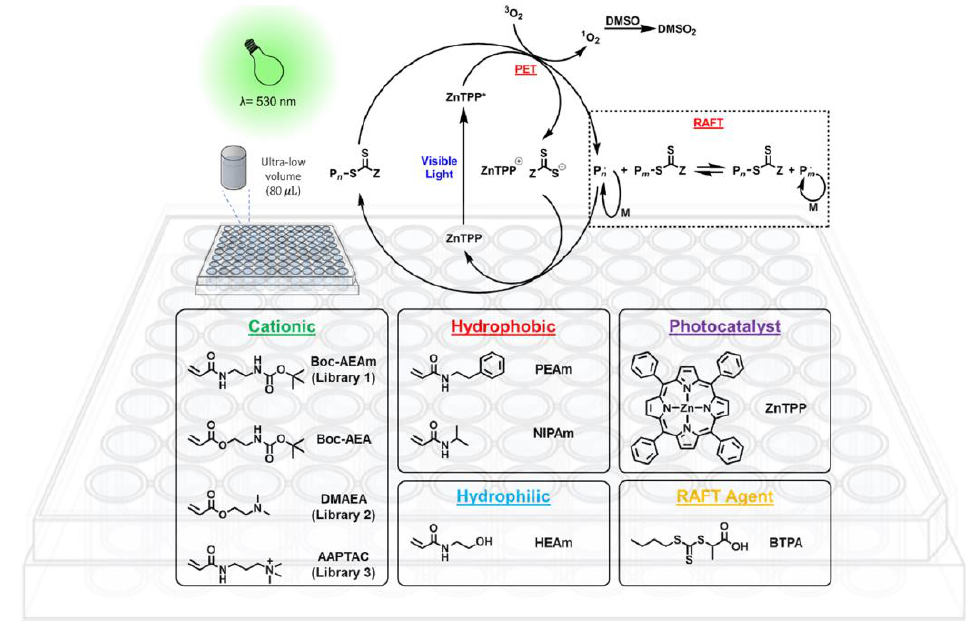
Figure 20. Schematic representation of PET-RAFT process. Reproduced with permission from ref. [121].